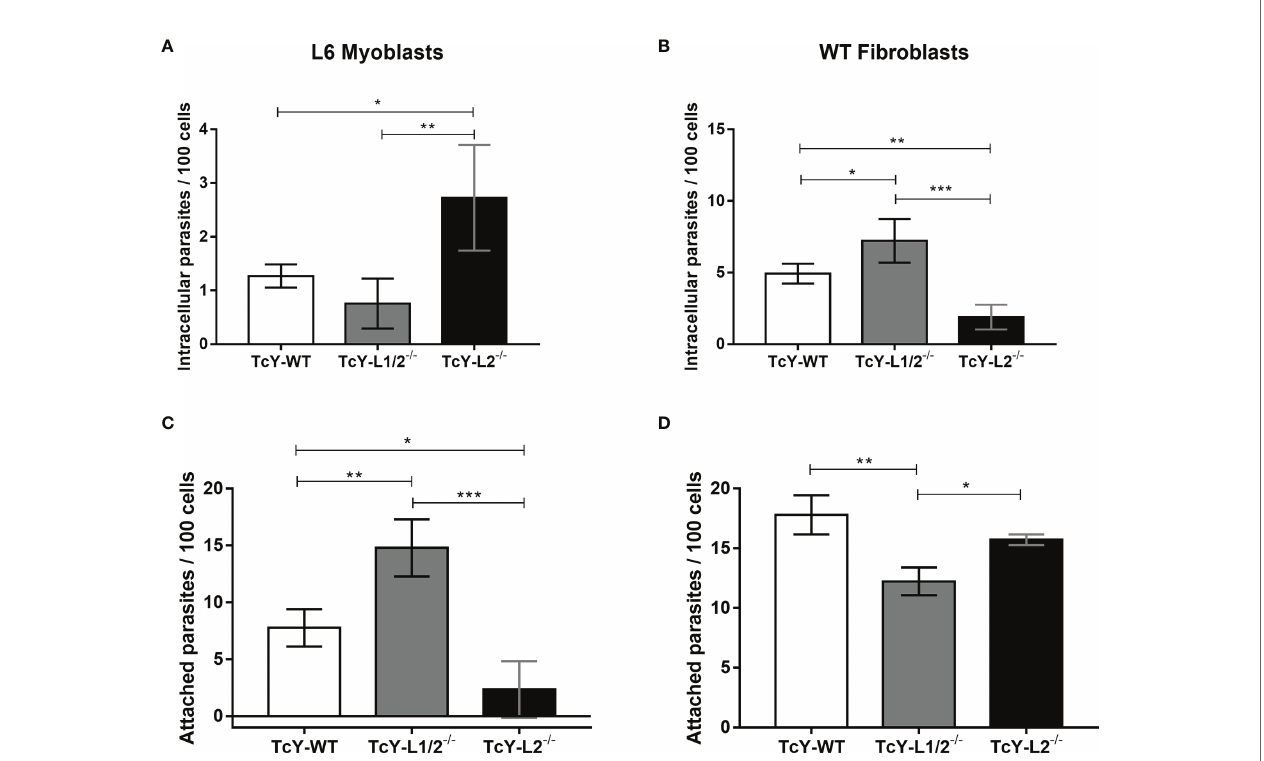
FIGURE 1 | Parasite invasion and adhesion rates are altered by passage through WT or LAMP de fi cient fi broblasts but do not correlate to each other. Invasion assays (A, B) . L6 myoblasts (A) or WT fi broblasts (B) were exposed to TcY-WT, TcY-L1/2 − / − , and TcY-L2 − / − trypomastigotes for 40 min at an MOI of 50. Cells were fi xed with 4% PFA and labeled with T. cruzi antibody and DAPI. Adhesion assays (C, D) . L6 myoblasts (C) or WT fi broblasts (D) were fi xed with 2% glutaraldehyde prior to incubation with to TcY-WT, TcY-L1/2 − / − , and TcY-L2 − / − trypomastigotes for 40 min at MOI of 50. Cells were fi xed with 4% PFA and stained with rapid panotic staining. Asterisks represent statistical signi fi cance between groups (*p < 0.05, **p < 0.01, ***p < 0.001, ****p < 0.0001, One-way ANOVA, Fisher ’ s